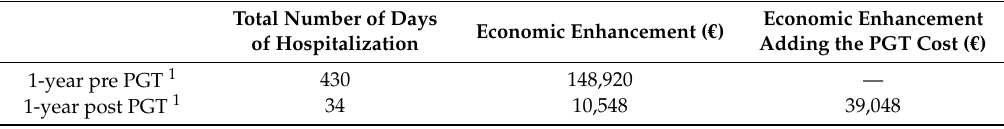
Table 5. Economic enhancement of days of hospitalization (pre- and post-change of